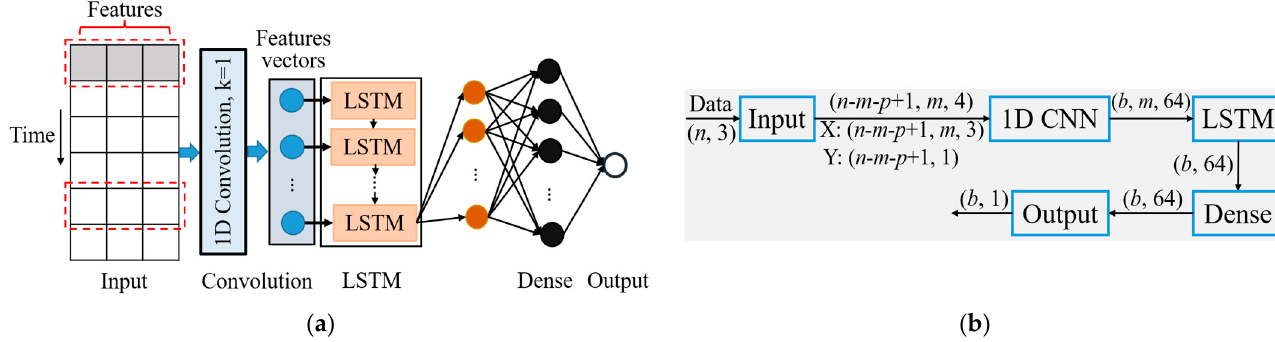
Figure 4. CNN-LSTM neural network car-following model structure, where ( a ) is the structure diagram of the proposed model, ( b ) is the flow of tensors in each layer, respectively. ( n , m, p, and b are the number of samples, memory time step, prediction time step, and batch size, respectively).